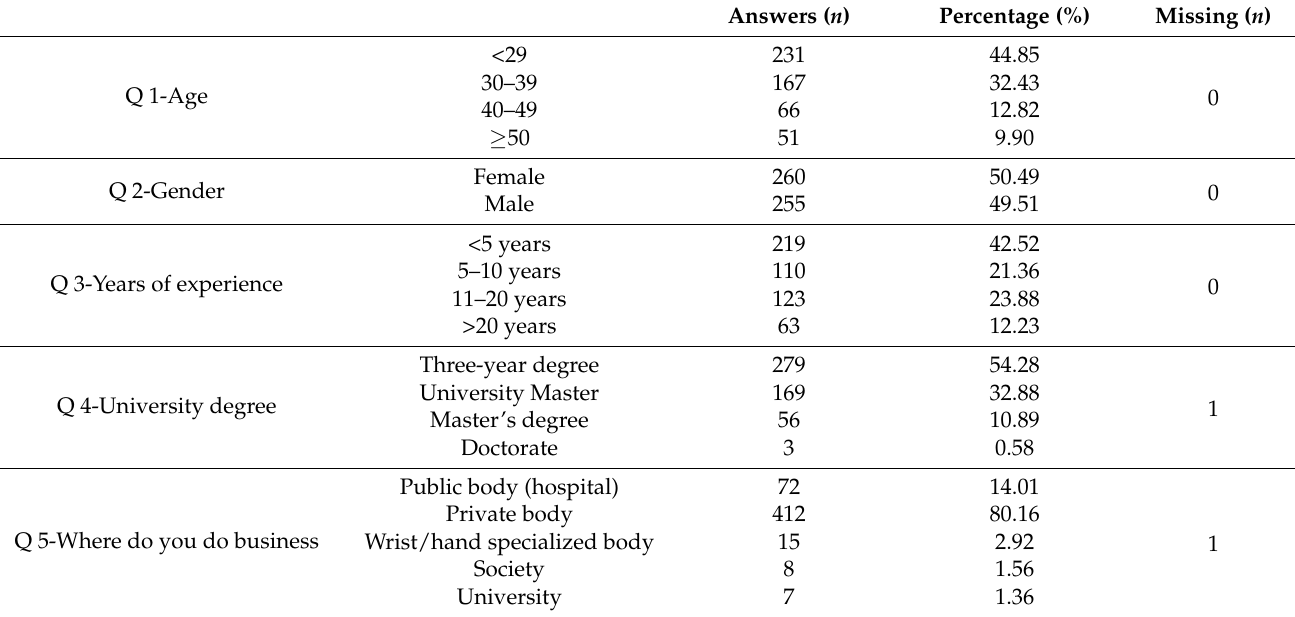
Table 1. Demographic characteristics of